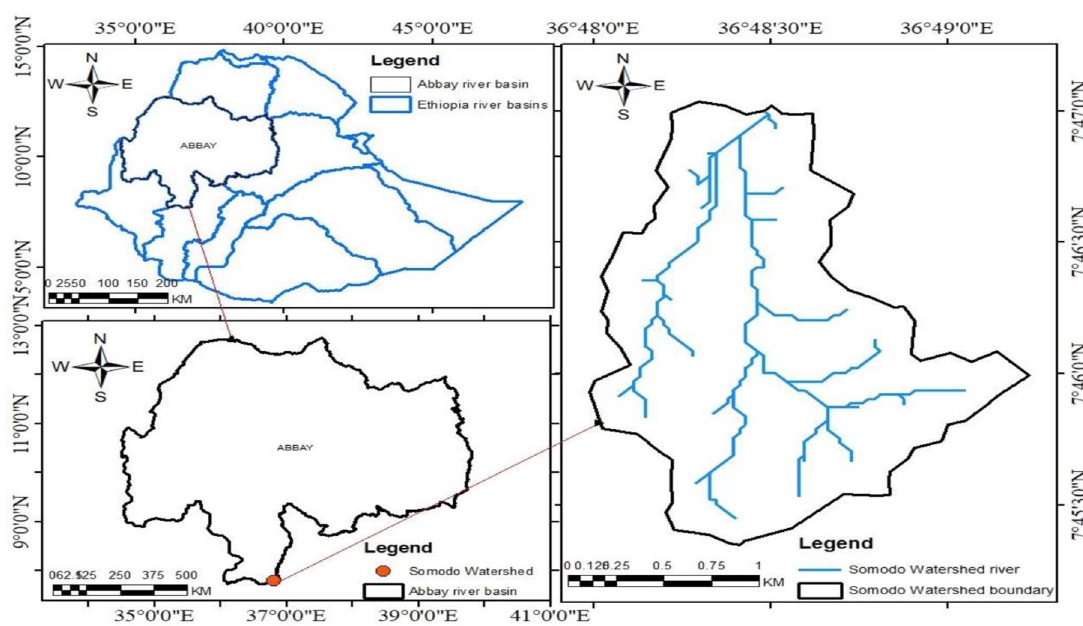
Fig 1. Map of Somodo watershed, Jimma zone, southwestern Ethiopia. Agroecology and soil: Somodo Watershed is characterized by the Agroecological zone of Tepid sub-humid and mid-highland (SH3). The altitude of the study area ranges from 1900 to 2075 m.a.s.l. The long-term means annual rainfall of the watershed is 1954.3 mm with the mean temperature of 19.3˚C ranging from 15.0 T min to 23.5 T max (Fig 2). Nitisols and Orthic Acrisols are the most dominant soil types of the area and Nitisols accounting for 64% of slightly acidic soil [17]. The textural class of the soil is sandy clay loam, while the pH is found to be strongly acidic [18].